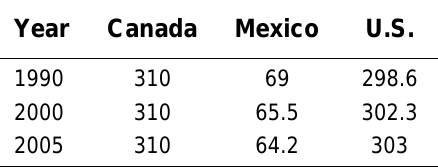
Total Forest Area (million ha)